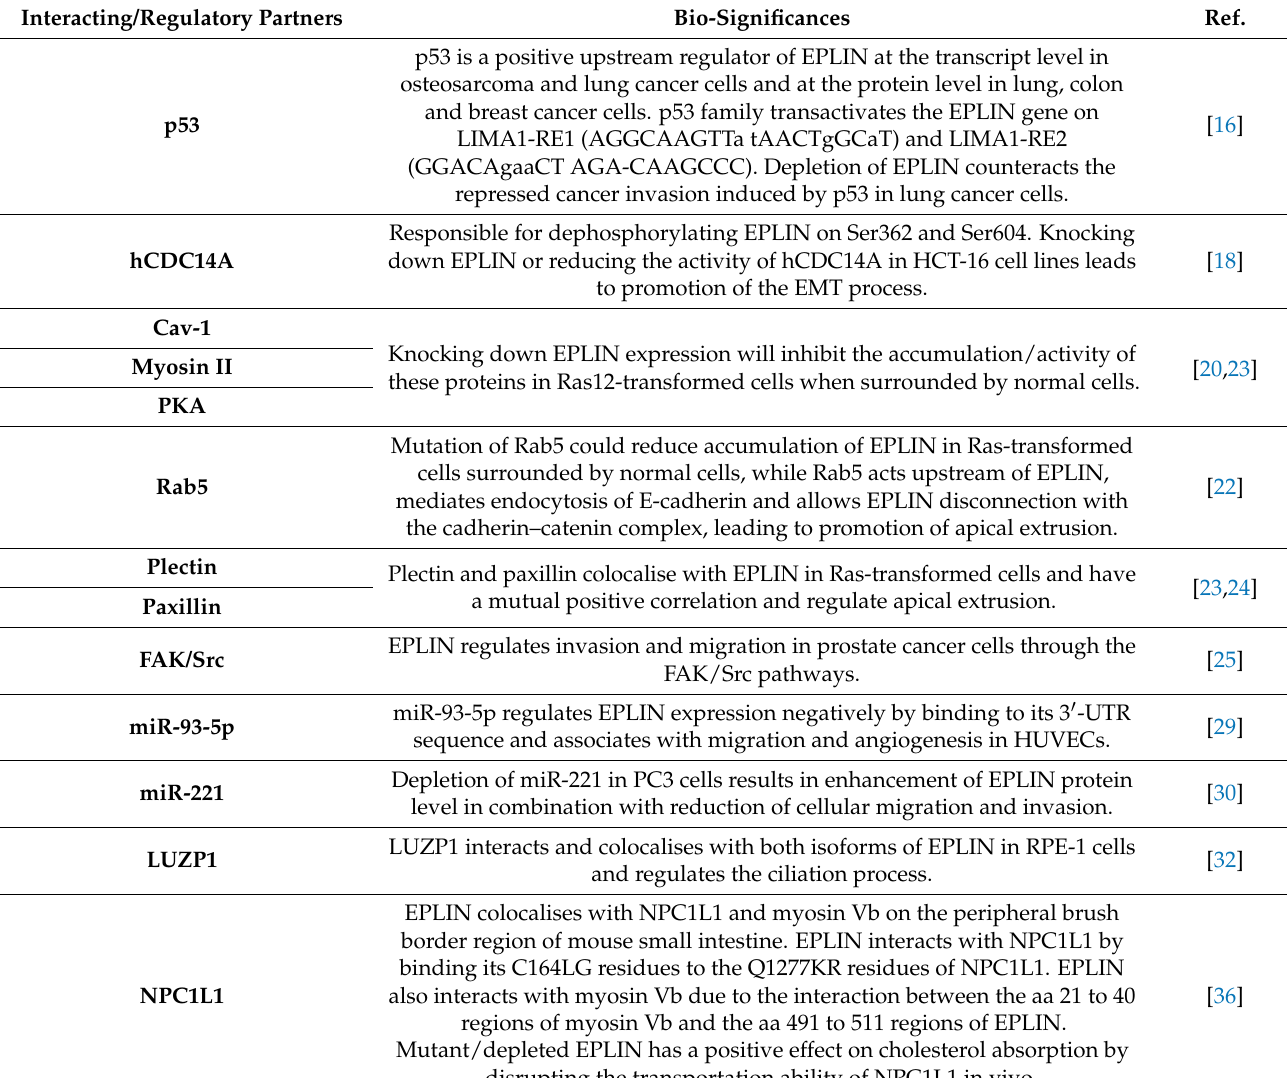
Table 1. Novel Interacting and Regulatory Partners of EPLIN. For previously described interacting partners, please refer to review papers from Collins et al. [2] and Wu et al. [3]. Interacting/Regulatory